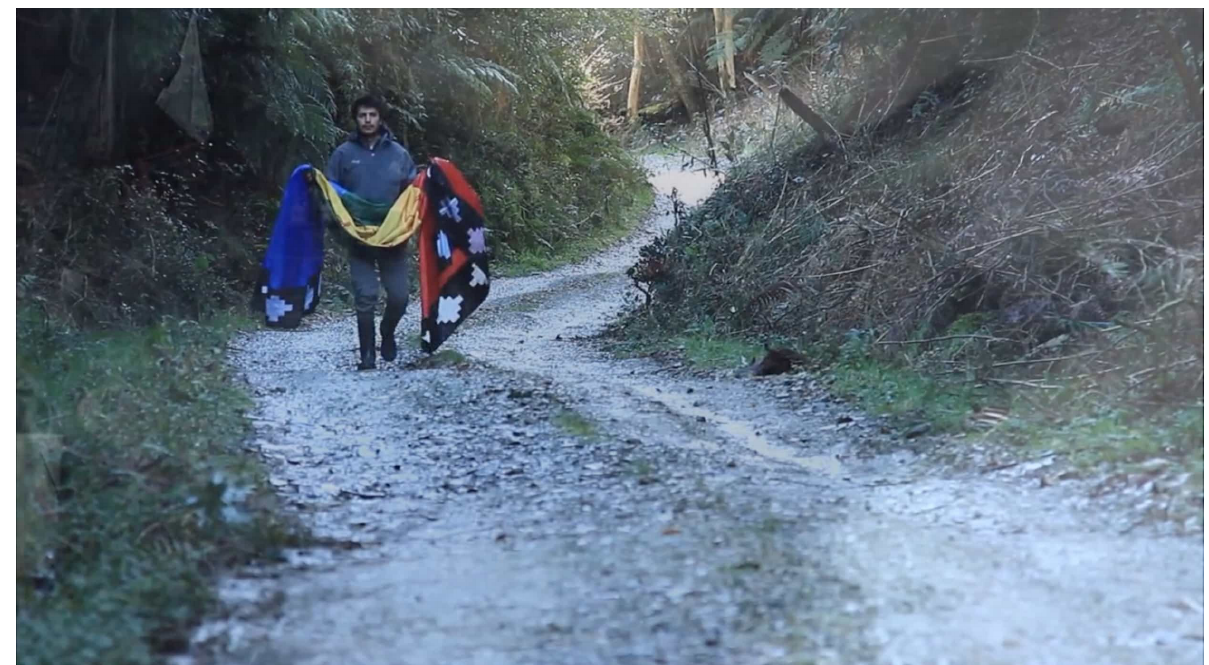
Figure 1: Still from Francisco Huichaqueo Pérez’s Ilwen, la tierra tiene olor a padre (2013) Video still courtesy of Francisco Huichaqueo Pérez. Film available at: https://vimeo.com/338142354?fbclid=IwAR3P-